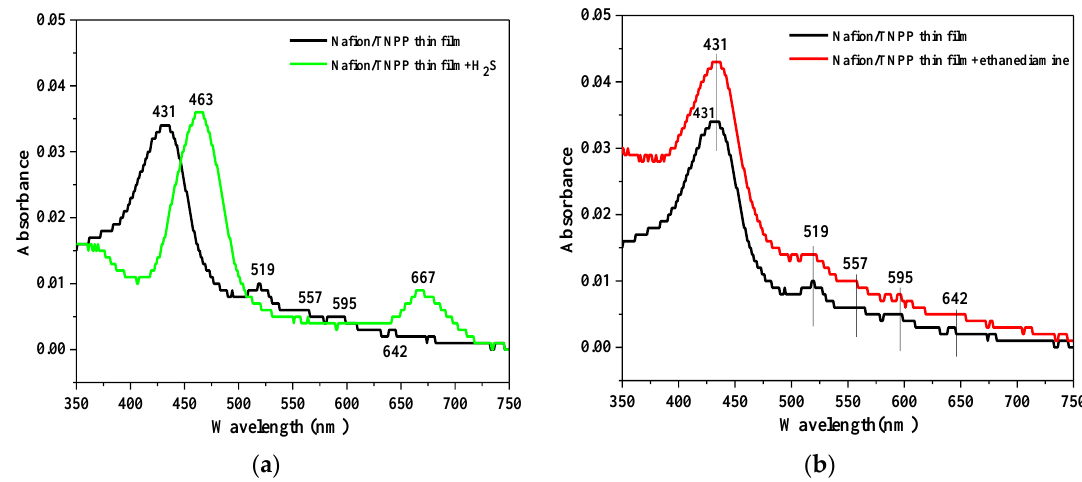
Figure 3. Absorption spectra of the Nf-TNPP film before and after exposure to ( a ) hydrogen sulfide (H 2 S) and ( b ) Ethanediamine (EDA) gas vapor.